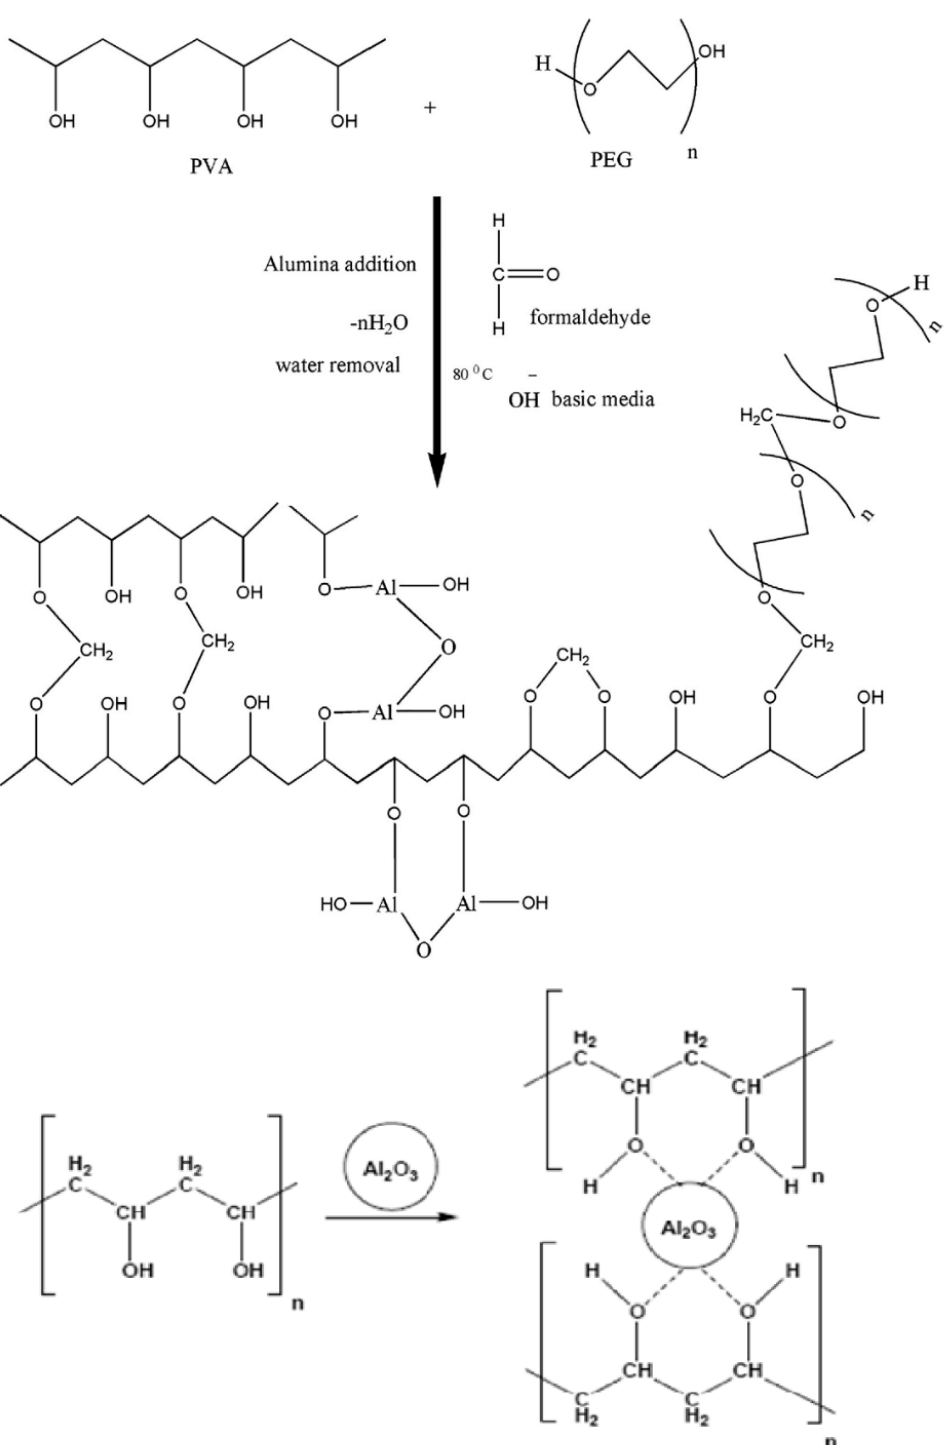
Figure 3. Proposed reaction scheme of alumina-filled cross-linked PVA/PEG polymers.